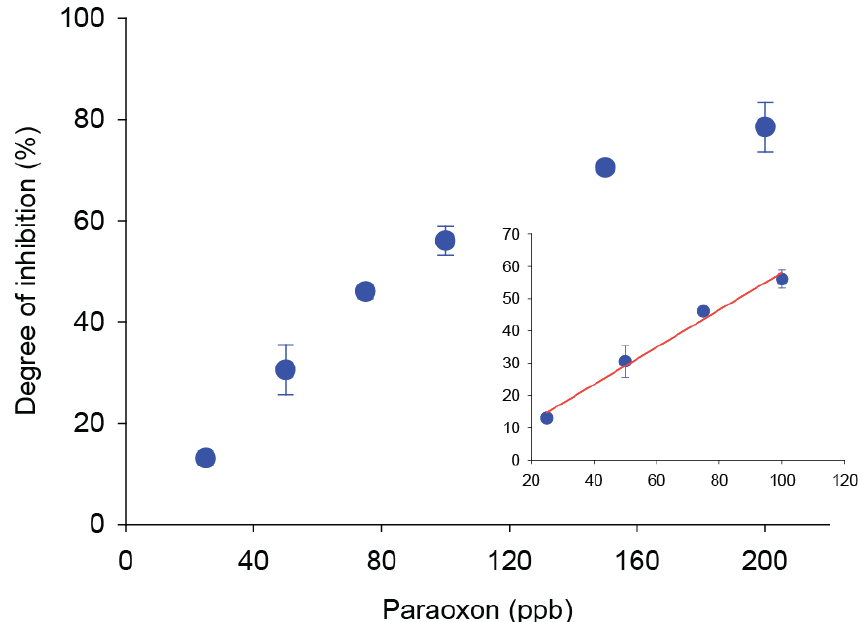
Figure 2. Calibration curve of paraoxon. Substrate: 5 mM butyrylthiocholine in phosphate buffer 0.05 M + KCl 0.1 M pH = 7.4, incubation time 20 min, applied potential +300 mV vs. Ag/AgCl ( n = 3). Inset: Linear range of the calibration curve.